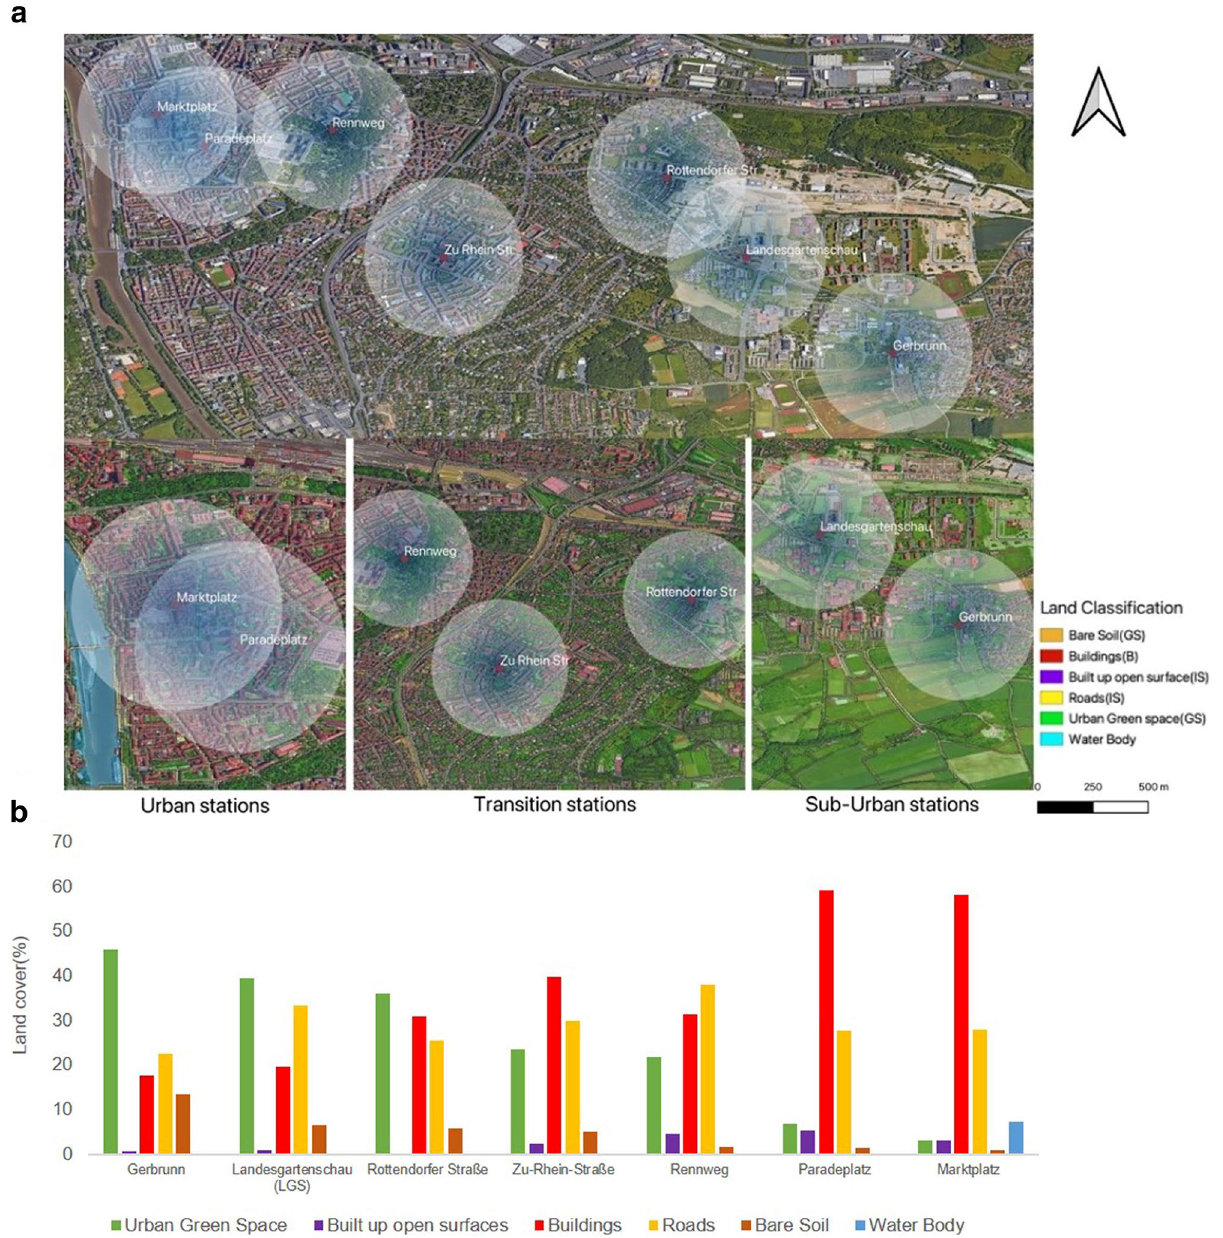
Figure 1. Study area—the city of Würzburg across the urban-sub-urban transect ( a ) and Land use land cover classification within the 500 m buffer of each measuring station ( b ). The land cover map of the study area was obtained using an object-based image classification approach applying standard nearest neighbour classifier on a Sentinel-2A image, later verified with Google Earth images. The map was generated using QGIS 3.10.0-A Coruña (https:// qgis. org/ en/